Question: From the figure, is the trend upward or downward?
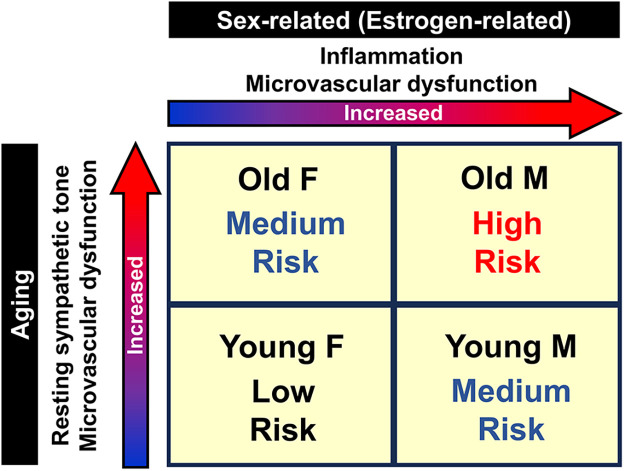
Answer: increasing